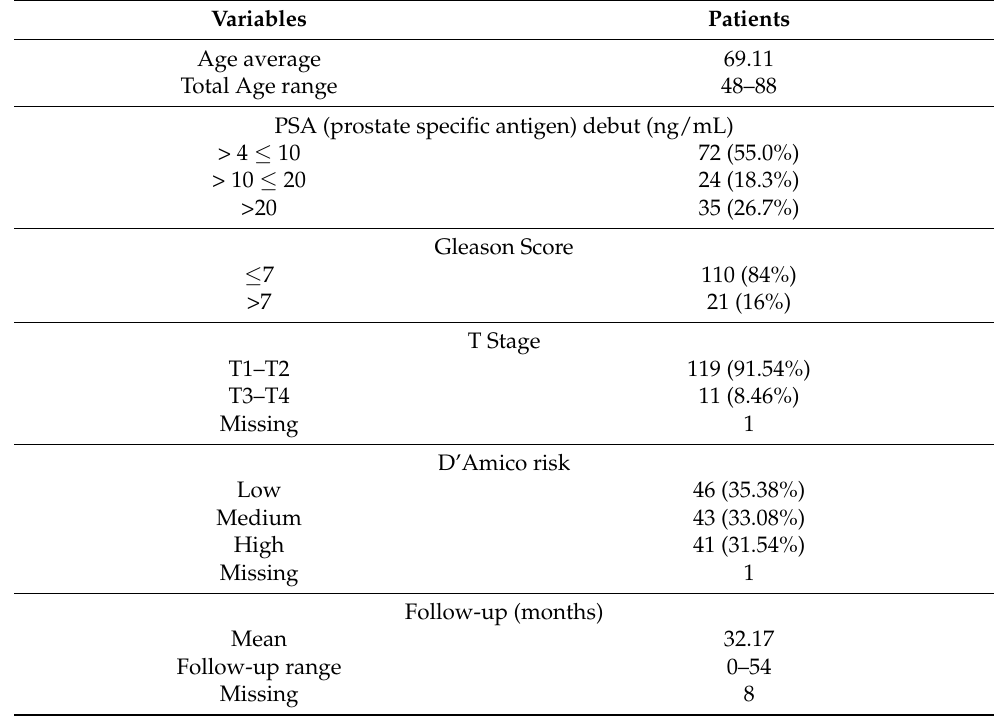
Table 1. Descriptive characteristics of PC tissue samples ( n =